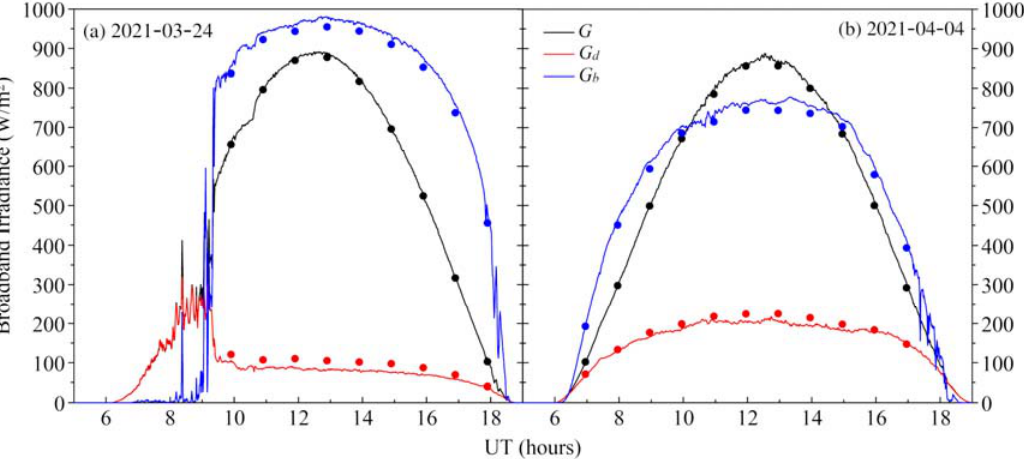
Figure 8. Diurnal variation of measured global ( G ), diffuse ( G d ), and direct ( G b ) broadband irradiances (solid lines) for two days selected to test the reliability of the method developed to extend the direct spectrum: ( a ) 2021-03-23; ( b ) 2021-04-04. The corresponding broadband values derived from the extended SMARTS spectra are also shown as dots. In the left plot, no such results are reported before 0930 UT because of cloudiness ( G b ≈ 0).